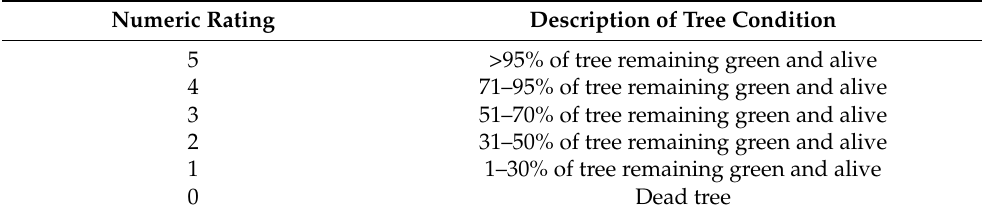
Table 1. Modified tree health scoring system for parkinsonia under field